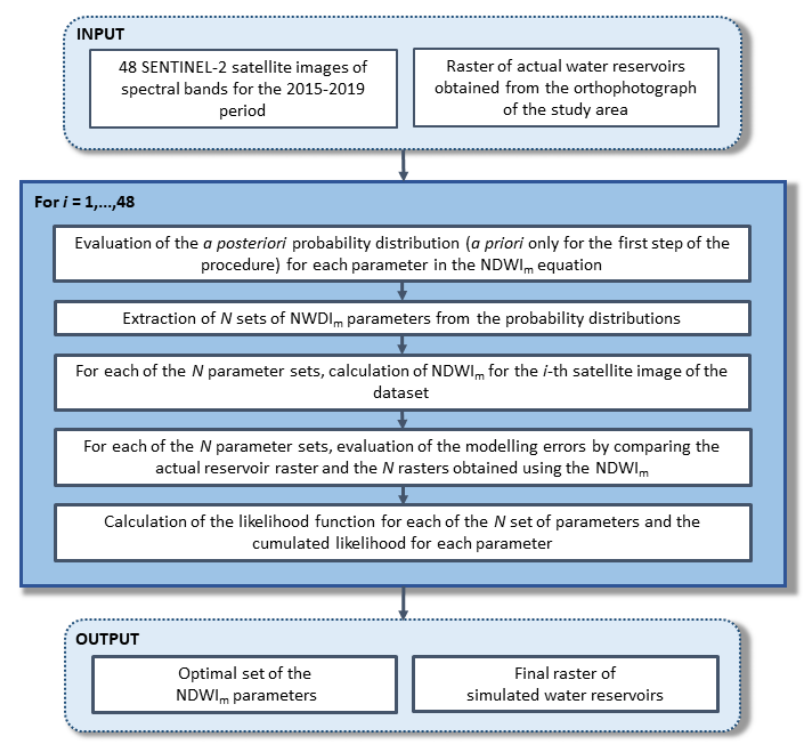
Figure 1. Flowchart of the proposed procedure.